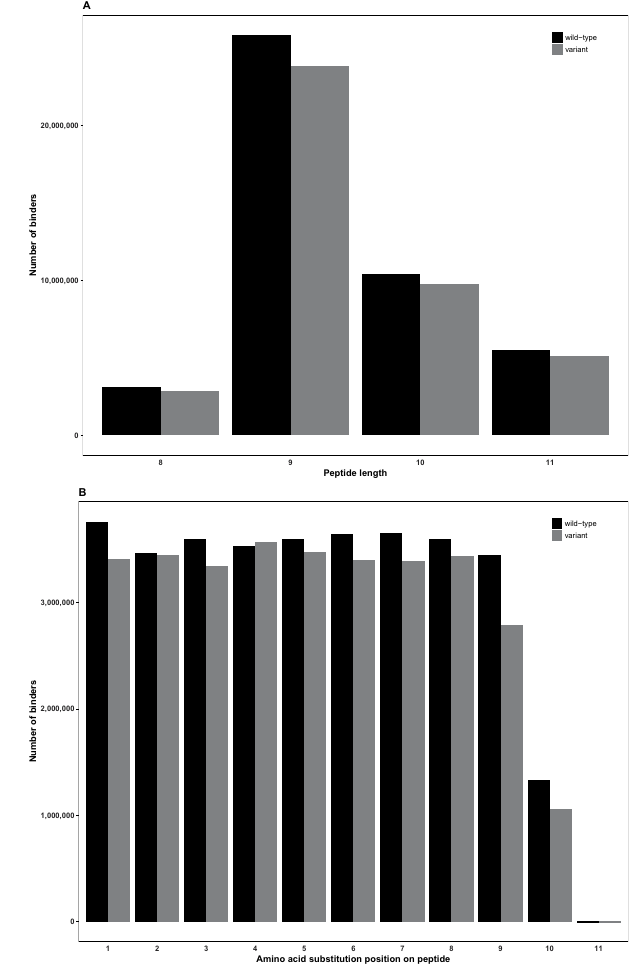
Figure 1. Distribution of 8- to 11-mer binding peptides and AAS distribution at positions 1–11. ( A ) Distribution of predicted peptide binders of lengths 8, 9, 10, and 11. ( B ) Distribution of the position of AASs in the peptide binders. The low number of AASs at position 11 is due to the very small number for 11-mer peptides because AASs at position 11 can only occur in 11-mers. In both panels, wild-type peptides are indicated in black and variant peptides in